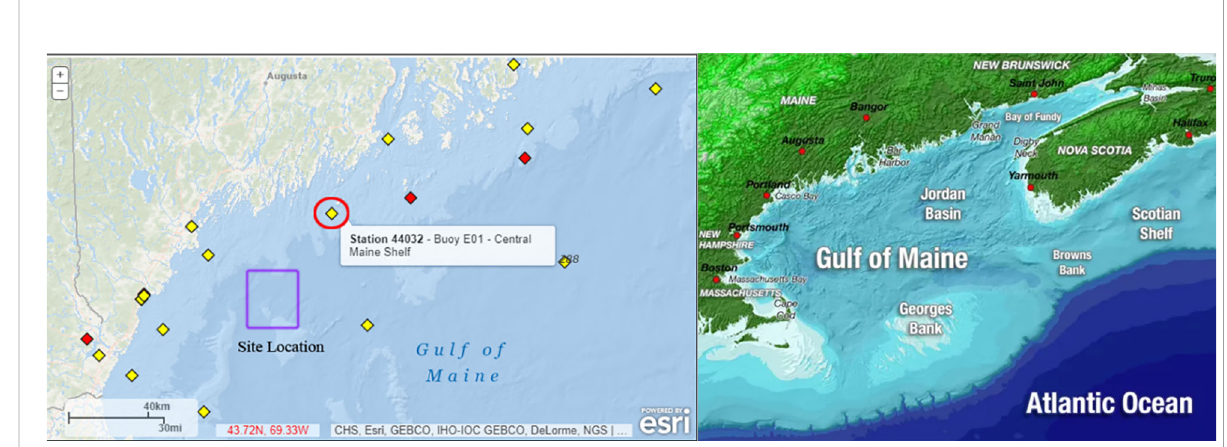
FIGURE 11 Proposed location of the offshore wind farm (left) and the location of the Gulf of Maine (right). https://www.noaa.gov/, https://www. tradeonlytoday.com/environmental-issues/study- fi nds-gulf-of-maine-is-getting-warmer).